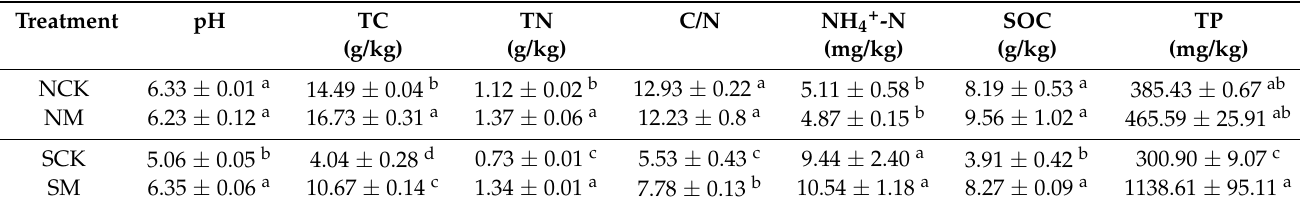
Table 1. Soil physicochemical properties of the studied soil samples.